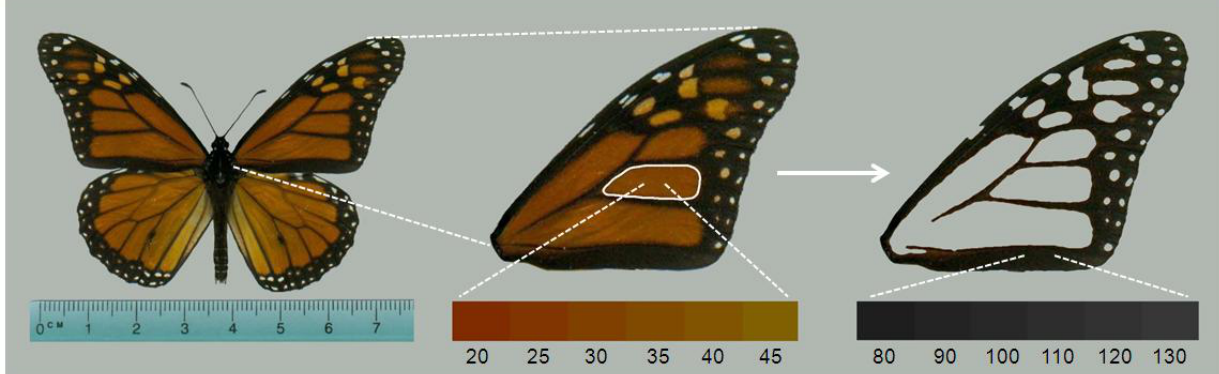
Figure 2. Wing parameters measured on monarchs. One forewing was removed from the specimen and scanned. Image analysis produced measures of forewing area, hue score of the orange color in the central cell (white outline), and melanism score (measured with pixel density) of all black areas of forewing. Lower bars (connected to images by white dashed lines) show the range of hue and melanism scores typically seen in monarch butterflies and in this